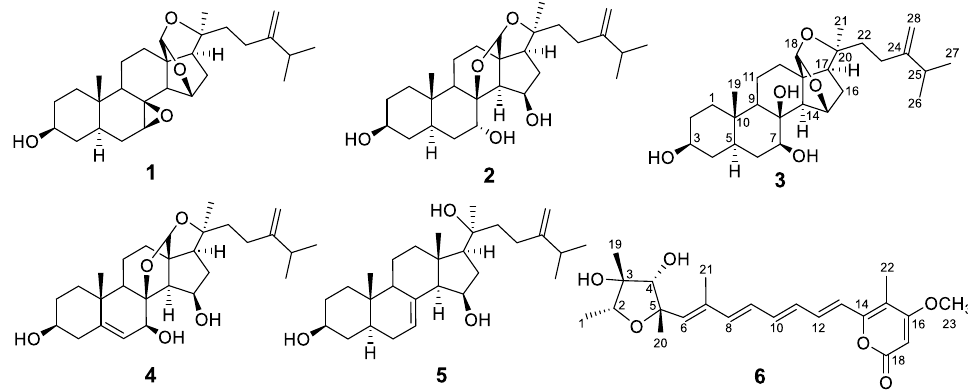
Figure 1. Structures of paxisterol ( 1 ), auransterol ( 2 ), (20 R )-7,8-dihydroxypaxisterol ( 3 ), (15R*,20S*)- dihydroxyepisterol ( 5 ), and 4-epi-citreoviridin ( 6 ) isolated during the previous study [1].